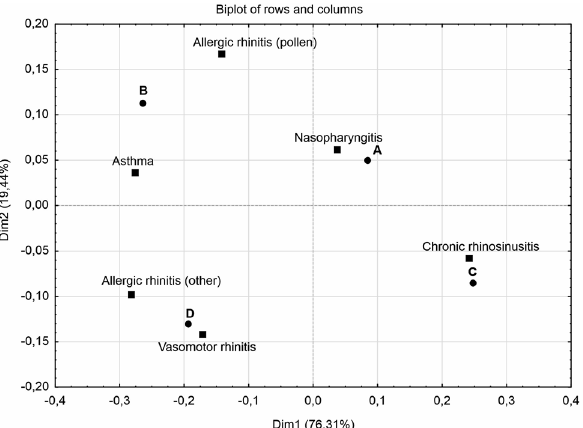
Figure 2. Percentage of patients with an increased level of eosinophils in relation to the nasal inflammation and the diagnosis. The following situations were considered: (A) Epith:Infl ≤ 1 and eosinophils ≤ 1%; (B) Epith:Infl ≤ 1 and eosinophils > 1%; (C) Epith:Infl > 1 and eosinophils ≤ 1%; (D) Epith:Infl > 1 and eosinophils >